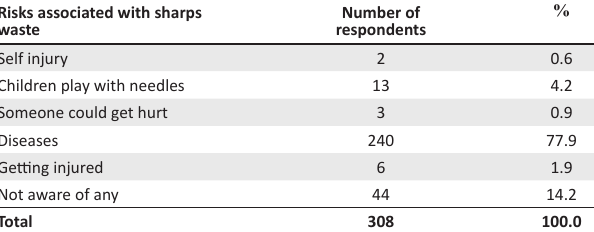
TABLE 3: Respondents’ perceptions of the risks associated with sharps waste. Risks associated with sharps waste